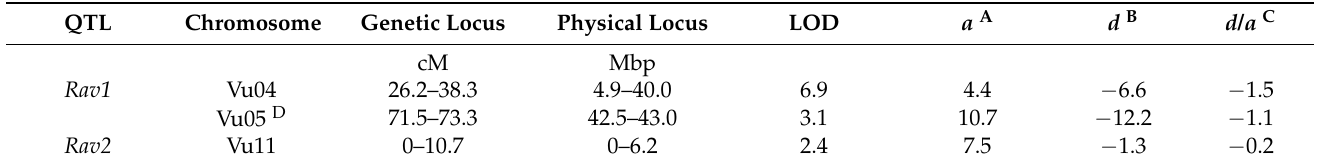
Table 3. Characterization of Alectra vogelii resistance quantitative trait loci (QTL). Putative QTL were identified by categorical trait multiple interval mapping (CT-MIM). The QTL intervals are delineated by a 1-logarithm of the odds (LOD) confidence interval. Positive additive effects ( a ) indicate increased Alectra susceptibility associated with inheritance of the susceptible parental genotype (524B). Negative dominance effects ( d ) indicate resistance was dominant over susceptibility. The degree of dominance ( d/a ) was calculated where d/a < − 1.0 indicates underdominance, d / a > 1.0 indicates overdominance, and − 1.0 < d / a < 1.0 indicates partial